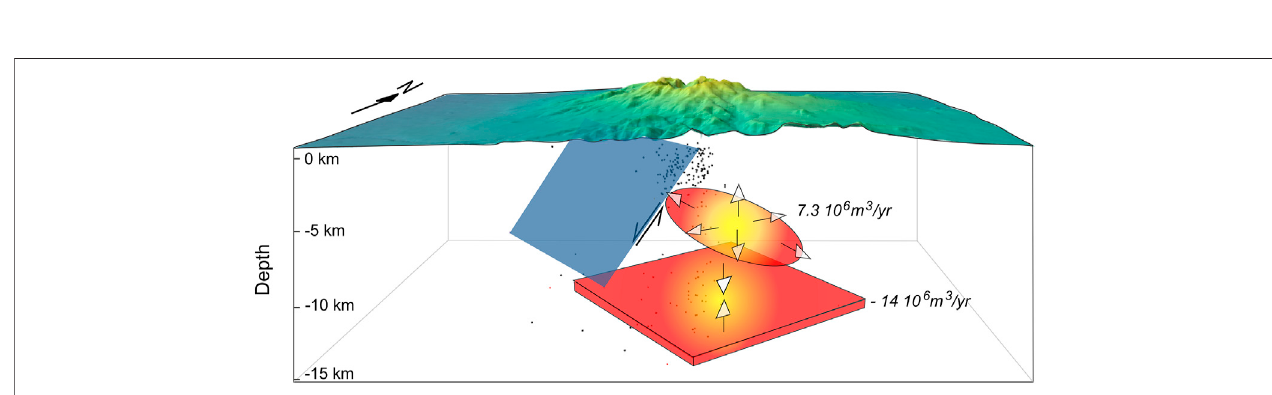
FIGURE 5 | Schematic of the sources of deformation at Changbaishan volcano. The plot is in scale, with double elevation for the topography. The seismicity between 2002 – 2006 is reported with black dots.